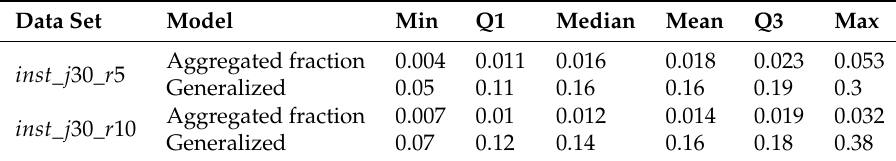
Table 9. Relative gap value summary for instances of datasets inst _ j 30_ r 5 and inst _ j 30_ r 5, with 5 min time